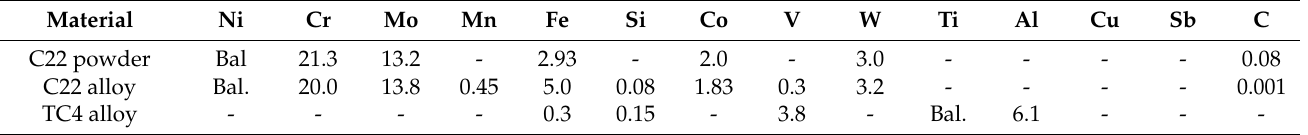
Table 1. Chemical compositions of the C22 powder, C22 alloy, and TC4 alloy in